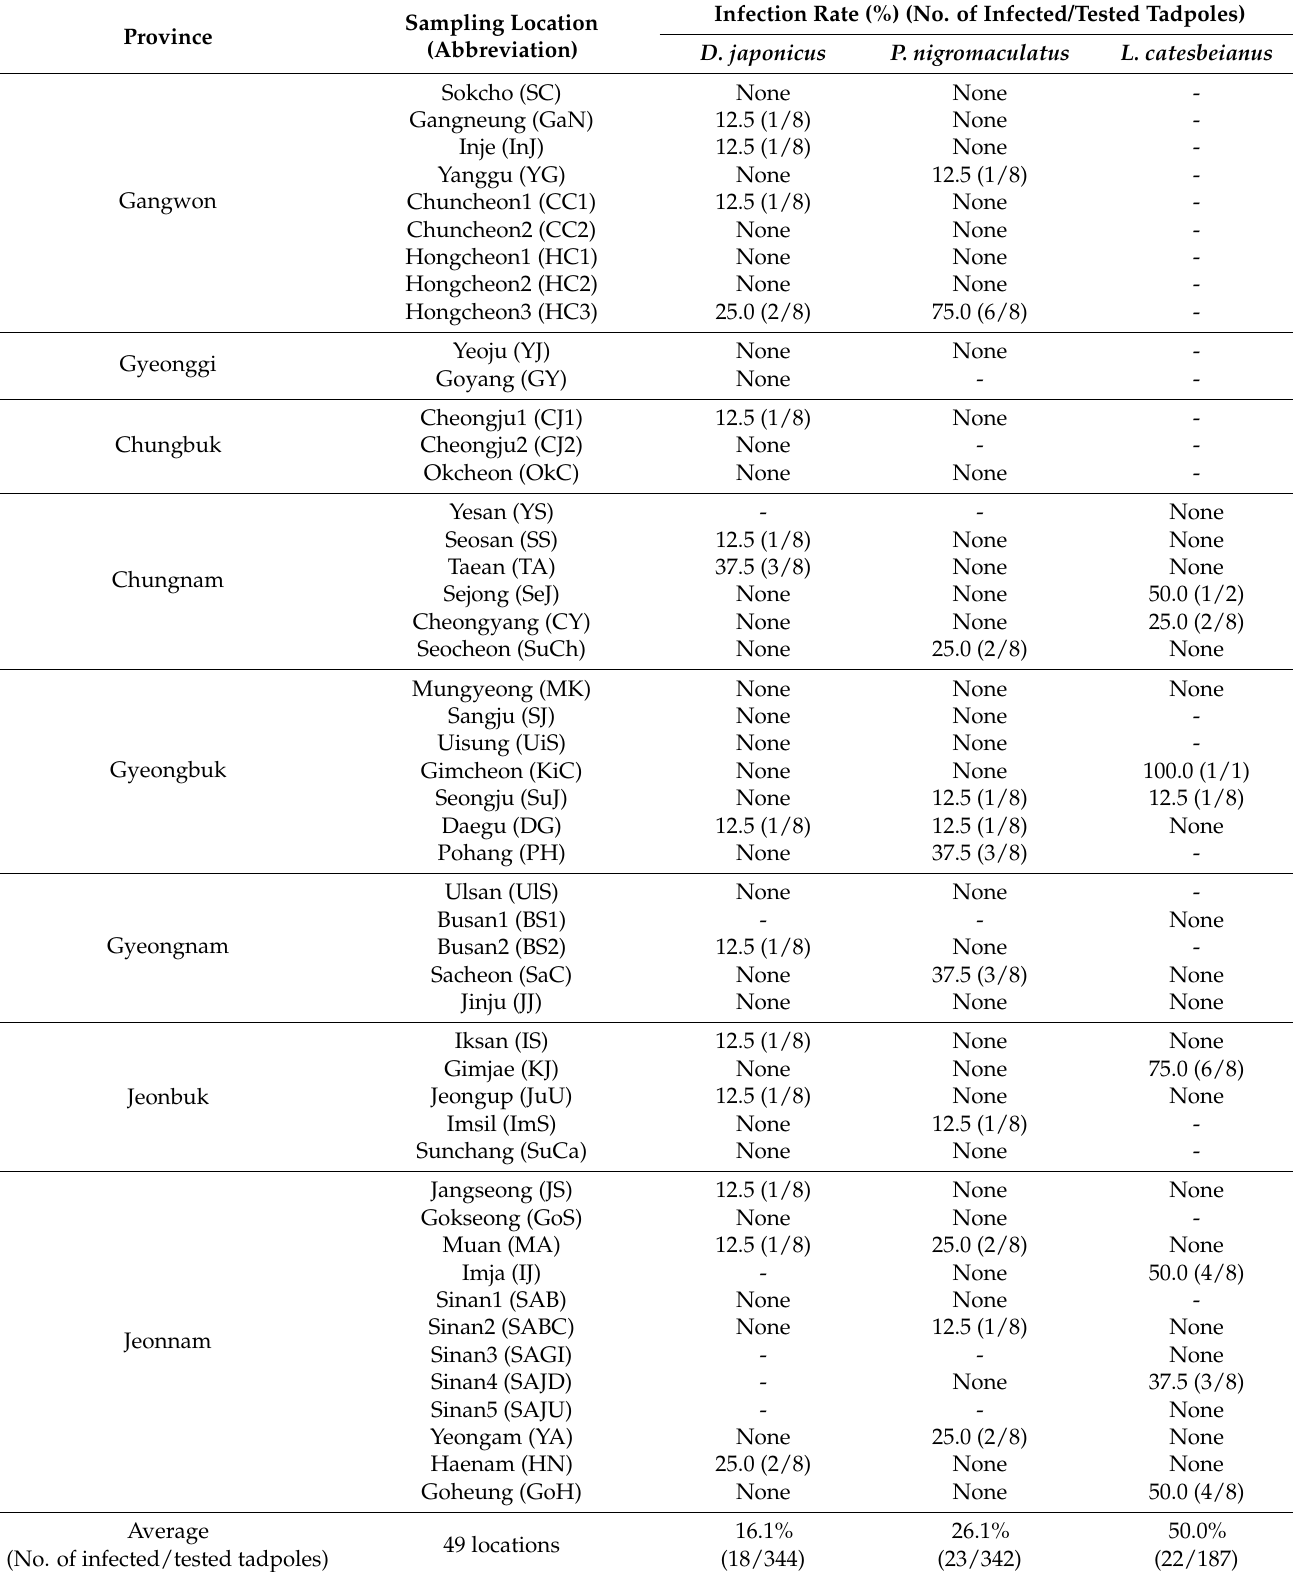
Table 1. Sampling locations and ranavirus infection rates in larvae of three anuran species (